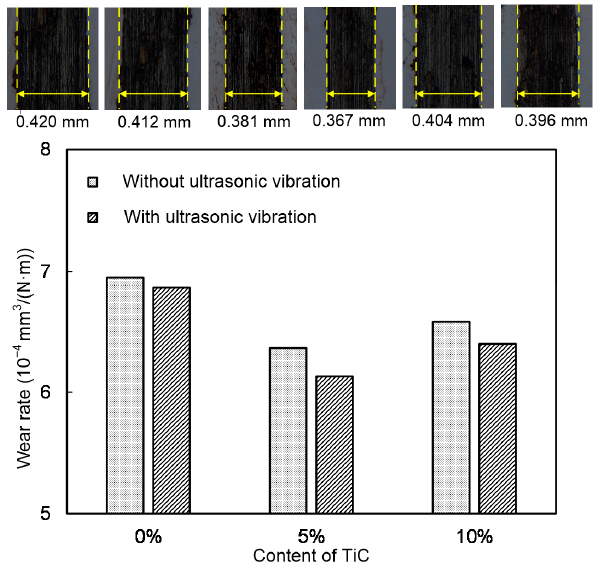
Figure 9. The effects of ultrasonic vibration and TiC content on microhardness. Table 4. The average friction coefficient of the CP-Ti and TiC-TMC coatings. Conditions Friction Coefficient CP-Ti without UV 0.322 0.324